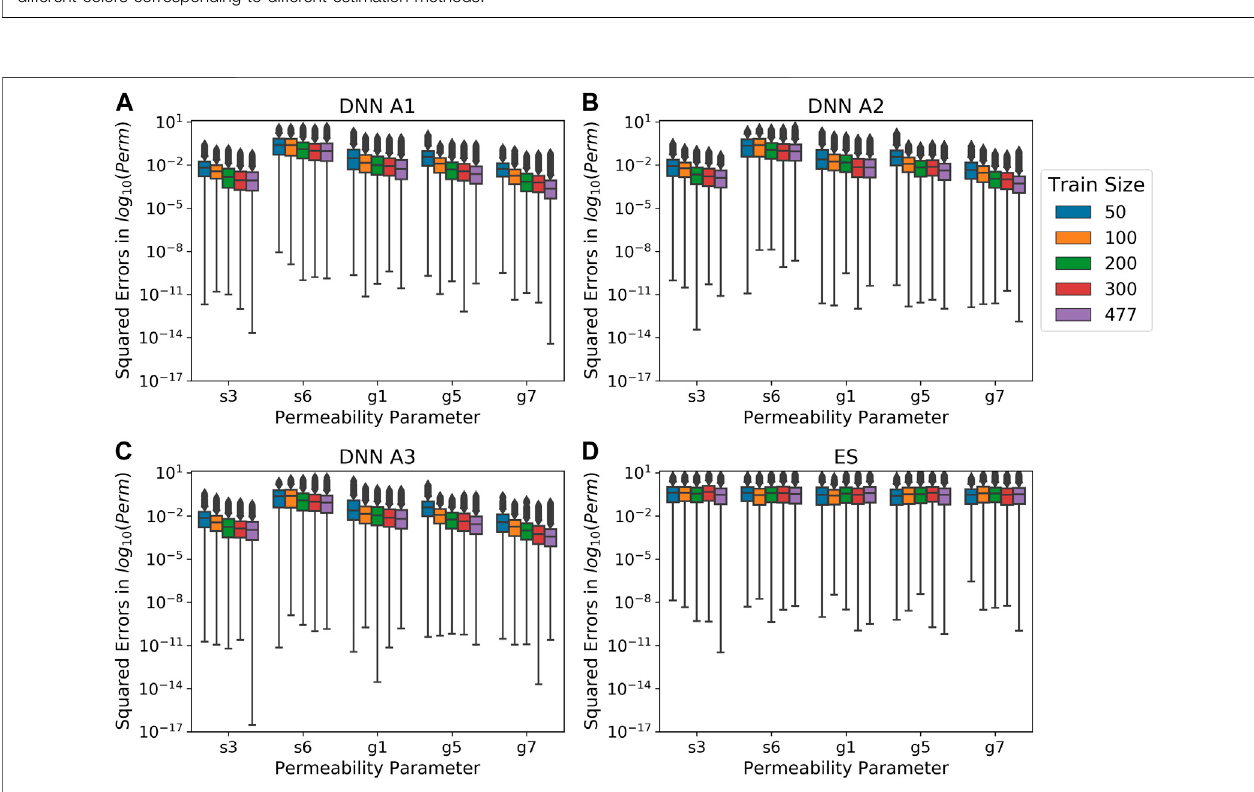
FIGURE 9 | Box plots of squared errors on permeabilities estimated by DNNs and ES for the testing set using relative observation errors of 0.05 with different trainingdatasizes.The x -axisisthepermeabilityparameter.The y -axisisthesquarederrorsofthelog 10 -transformedpermeabilityparameters.The y -axisisshowninlog- scale. Each color represents a number of realizations used to train the DNNs or ES (50, 100, 200, 300, 477). (A) the squared errors for the DNN A1 model; (B) the squared errors for the DNN A2 model; (C) the squared errors for the DNN A3 model; (D) the squared errors for the ES.